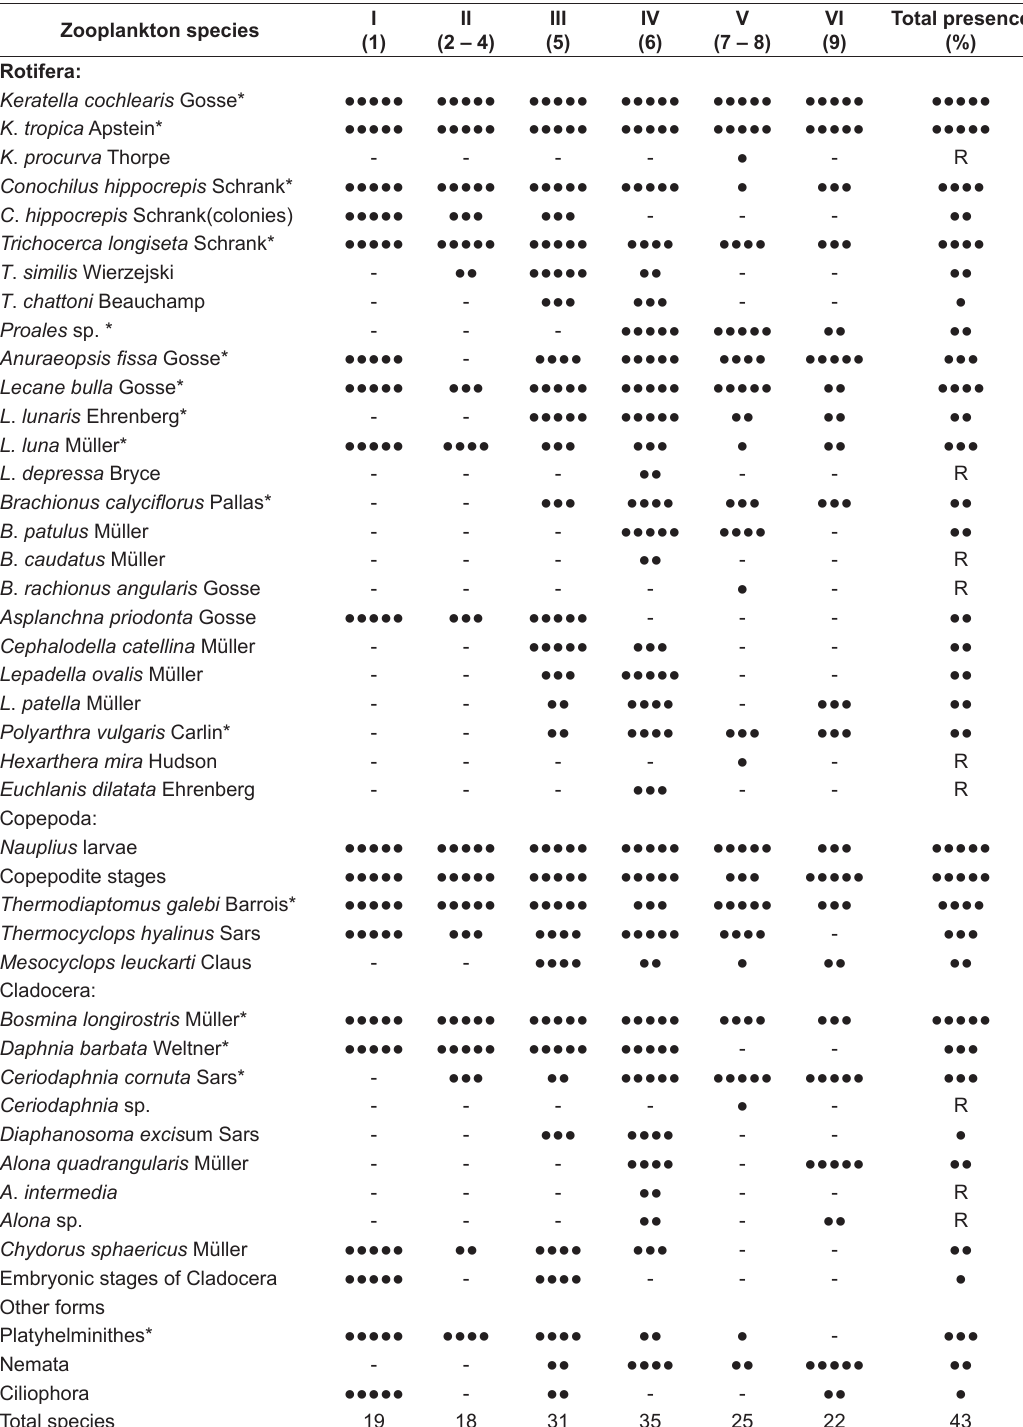
Table 3. Zooplankton species recorded along the main stream of the Nile in Upper Egypt and their presence contri- butions(%)of the nine zooplankton clusters distinguished after the application of Twinspan classification. Zooplankton